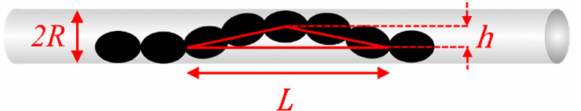
Figure 5. Estimation of triangle when doing calculations on the